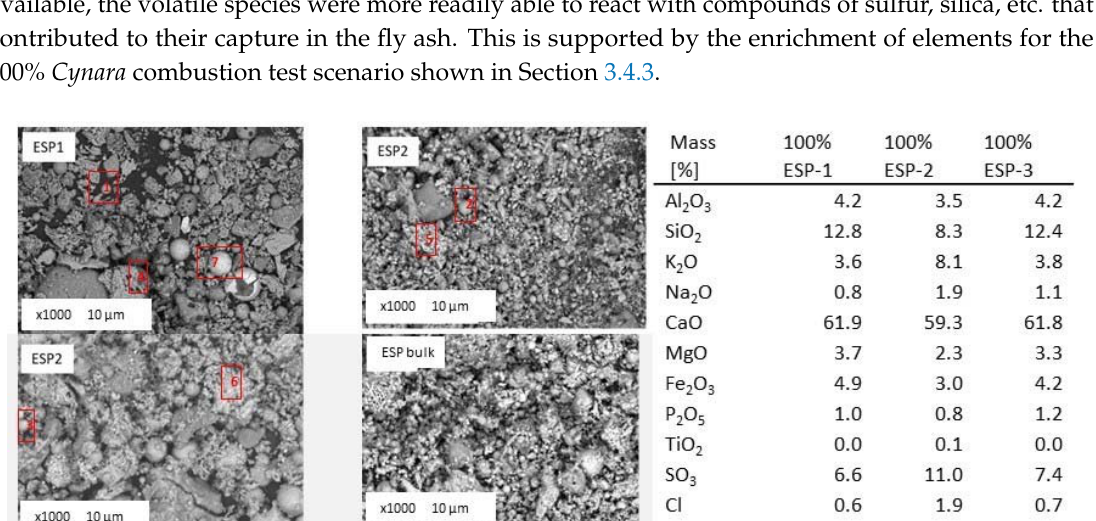
Figure 16. Backscattered electron images of FA from 50% thermal share Cynara co-combustion.